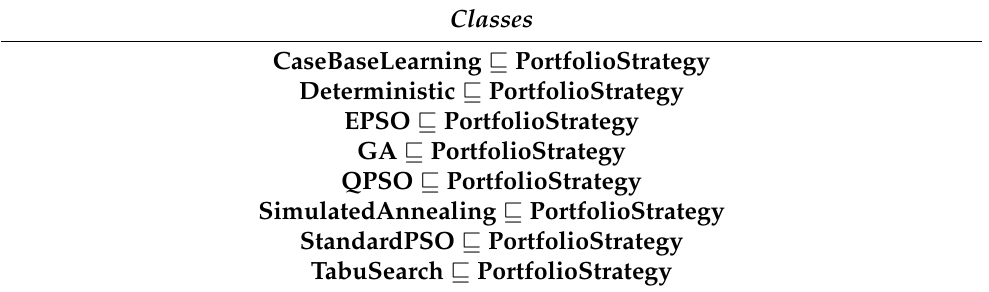
Table 6. AiD-EM Ontology PortfolioStrategy ’s sub-classes in DL syntax.